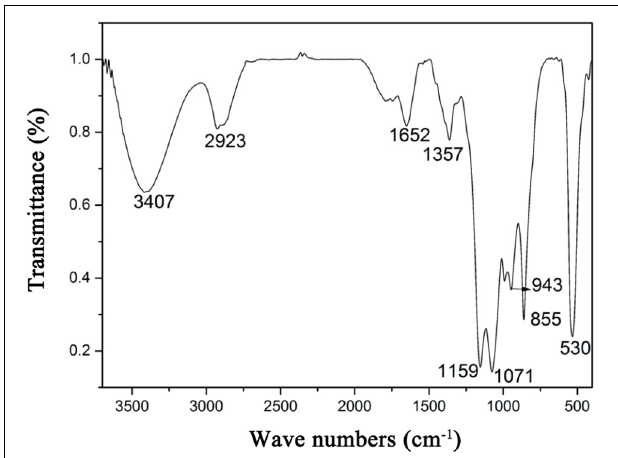
FIGURE 3 | Fourier transform infrared spectroscopy (FT-IR) spectrum of Heimioporus retisporus Polysaccharide